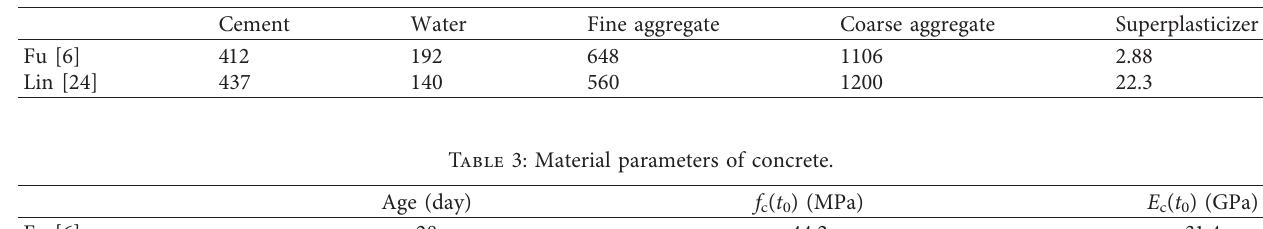
Table 2: Mix proportion of the concrete (kg · m − 3 ).